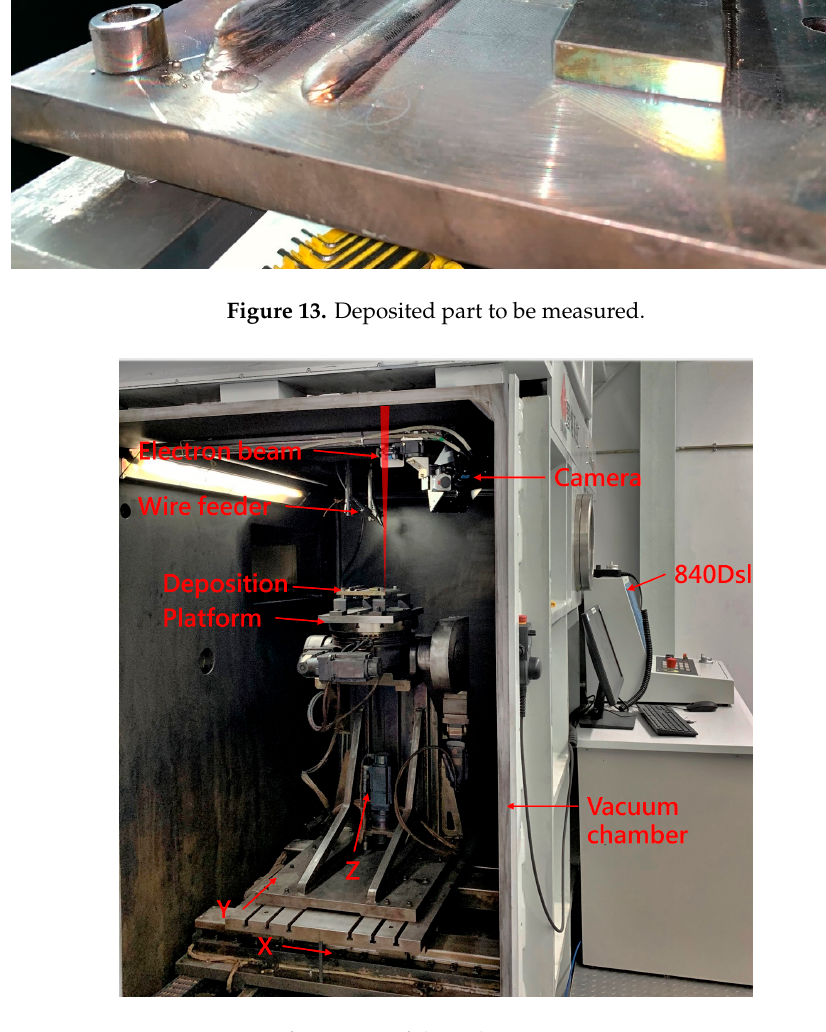
Figure 15. Measurement result of the deposit surface. To verify the accuracy of the method in the actual surface, the region shown by the red dashed line in Figure 15 is selected. It was a flat surface. Therefore, the detected height value of this region is subtracted from the average value to obtain the detection error distribution of this region. It can be seen from Figure 16 that the maximum error is less than 0.15 mm. The error distribution shows that the error in this region has obvious directionality. After outputting the error point cloud of the region, it can be found that there is an obvious tilt. This may be due to the unexpected gap between the standard block and the platform. The tilt error of the platform itself can also result in the measured upper surface of the standard block being not a horizontal plane. The surface was fitted using the least squares method to obtain a fitted surface, as shown in Figure 17.